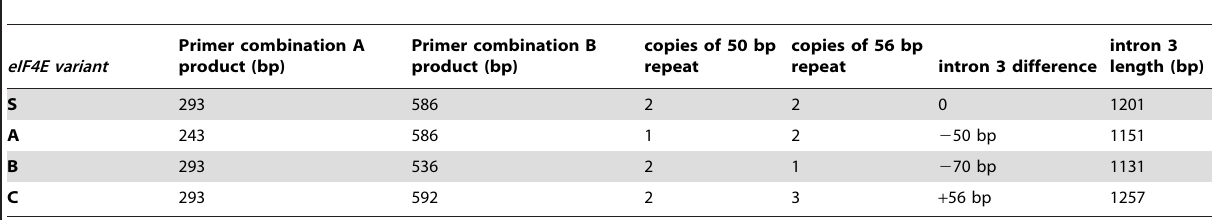
Table 1. Allele designation based on intron 3 length polymorphism, indicating size of obtained fragments with primer combinations A and B, number of repeat motives, intron 3 difference and total